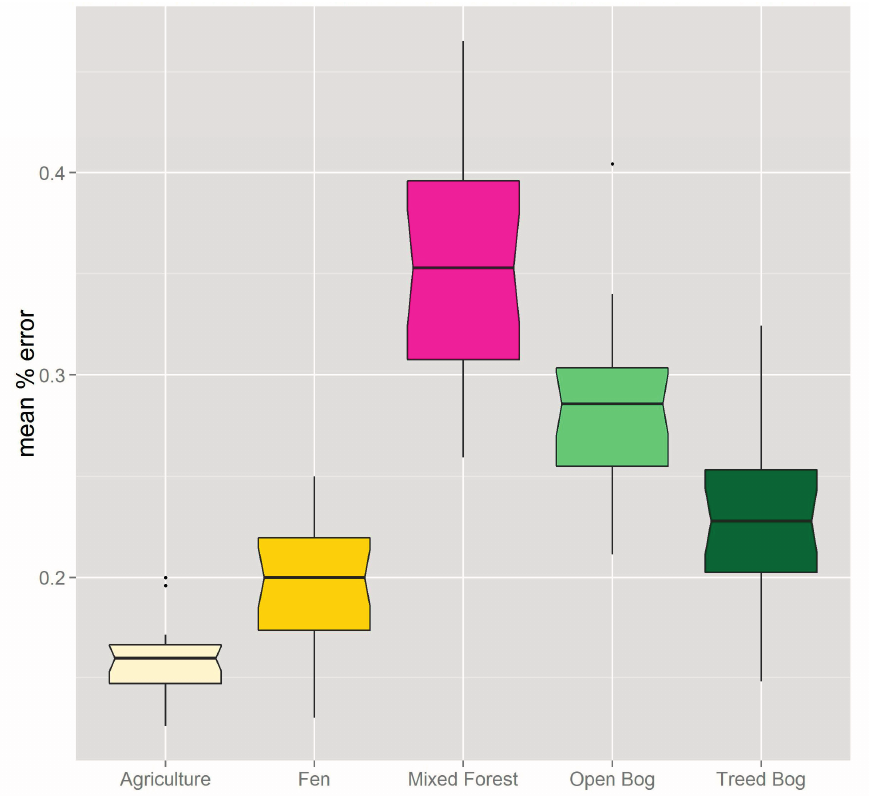
Figure 7. Boxplots showing mean classification error for each class based on 25 iterations of